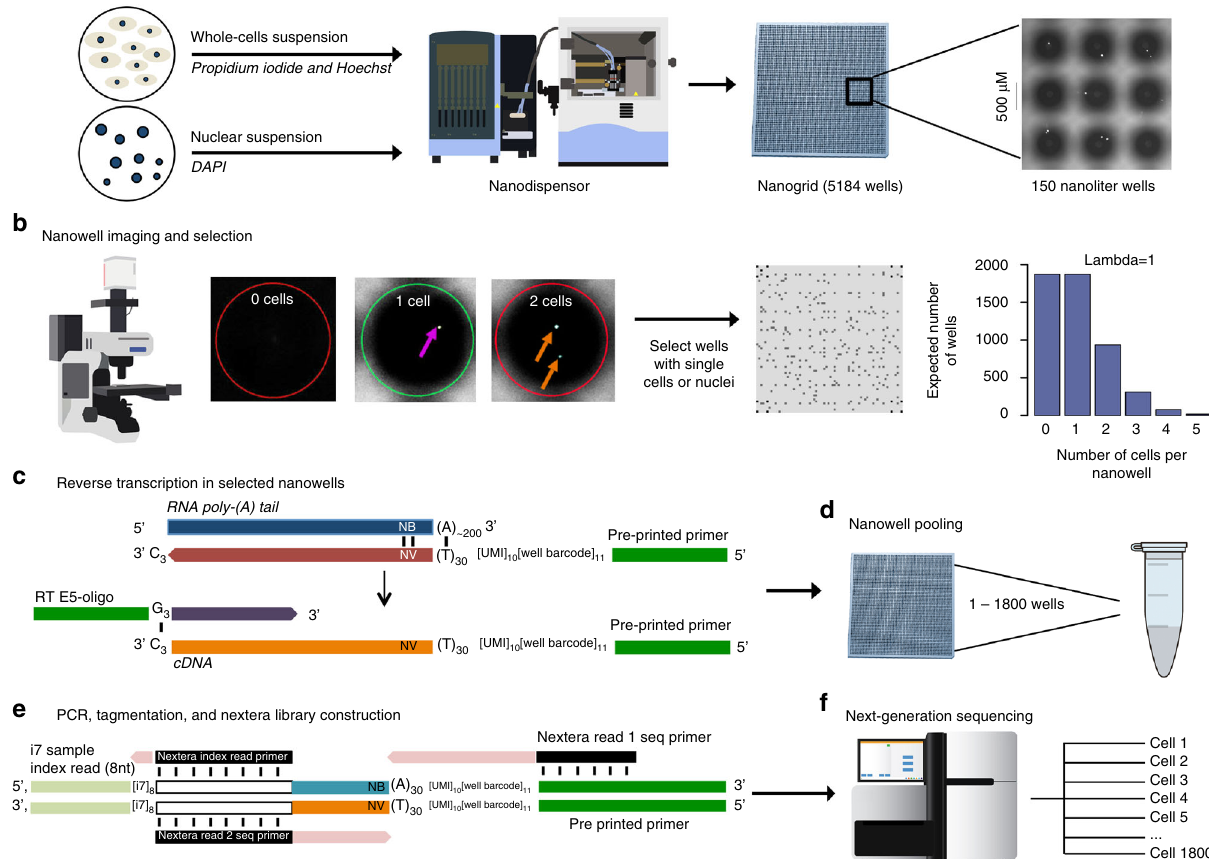
Fig. 2 Overview of the nanogrid single-nucleus sequencing method. a Nuclear or cellular suspensions are prepared and stained with DAPI (nuclei) or Hoechst and propidium iodide (cells) for nanodispensing into the 5184 wells in the nanogrid. Each nanowell is 400 – 600 μ m, and the well depth range is 950 μ m – 2.2 mm. The 500 μ m scale bar indicates the well diameter. b The nanowells are imaged using automated scanning fl uorescent microscopy and ~1800 wells containing single nuclei or cells are selected, while nanowells containing multiple cells, no cells or dead cells are excluded. c In the selected nanowells, the nanodispensor deposits lysis buffer and WTA reagents to perform reverse transcription of mRNA to cDNA using SCRB-Seq chemistry. This process also adds a UMI, well barcode and P5 adapter sequence to the (A) n tail. N represents A, C, G, or T; B represents C, G, or T; and V represents A, C, or G. d The barcoded cDNA with adapter sequences is pooled into a single reaction. e Nextera tagmentation is performed followed by PCR ampli fi cation to generate sequencing libraries with Illumina I7 indexes. f Next-generation sequencing is performed on the pooled libraries, after which the individual cell data is demultiplexed using the well